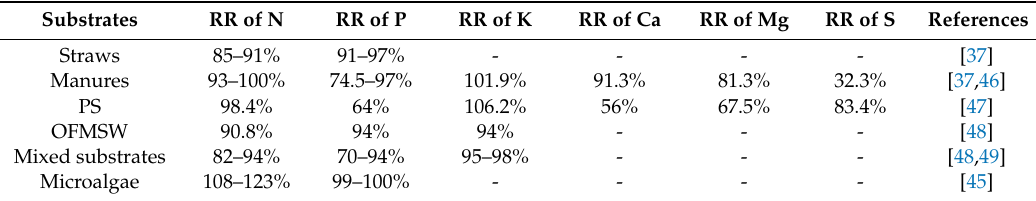
Table 3. RR of nutrients during AD of various